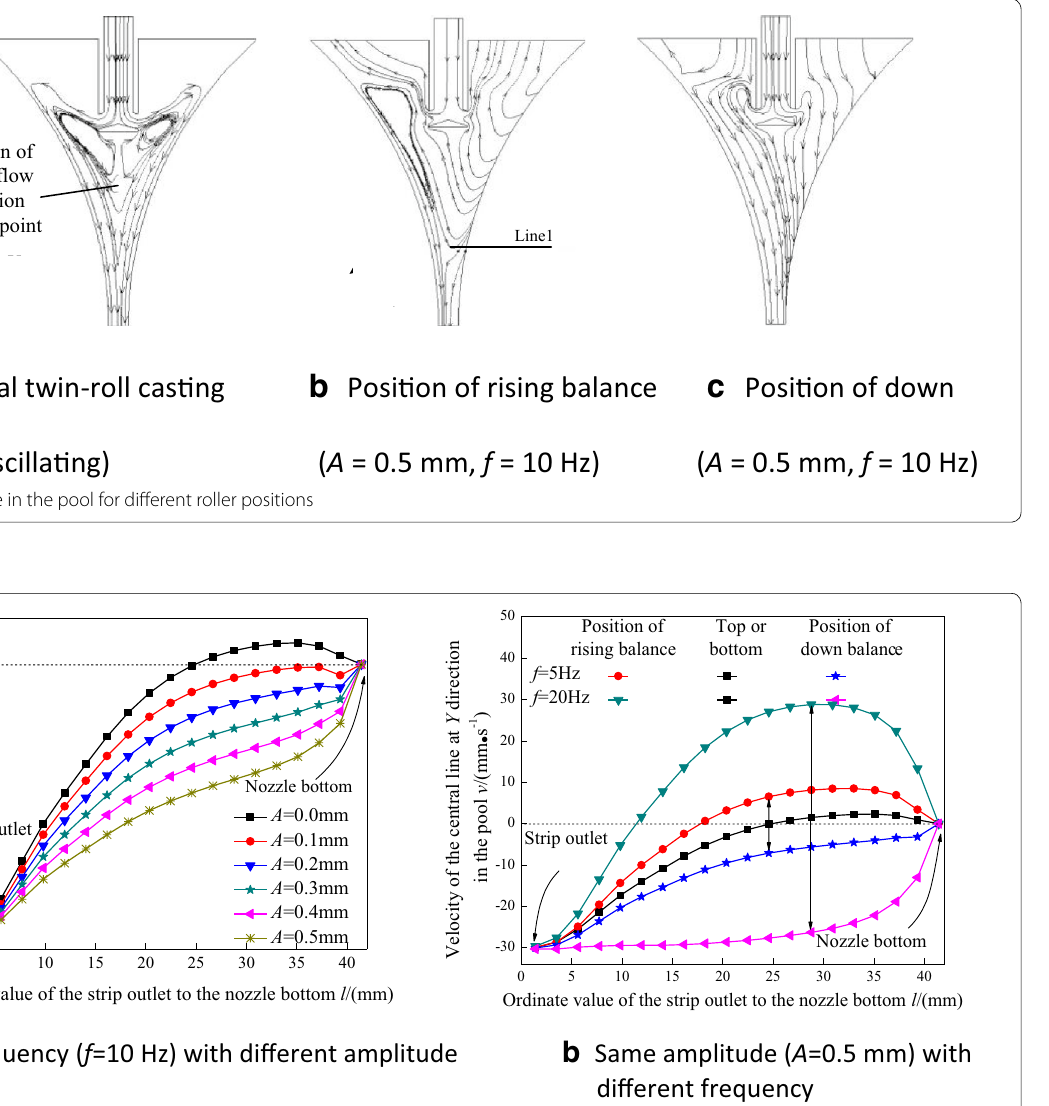
Figure 4 Velocity of the central line in the Y direction in the pool at the position of down